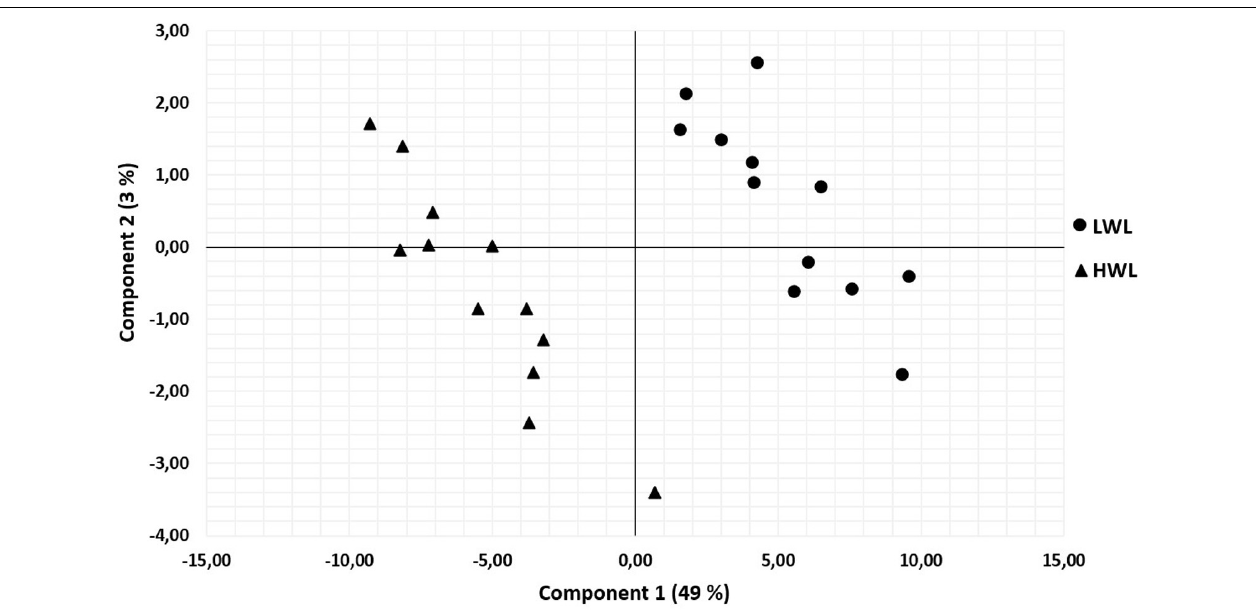
FIGURE 3 | Plot of the two first principal component score vectors showing variability according to the two liver weight groups for the 78 variant proteins ( n = 12/groups) : LWL = liver weight < 600 g = • , HWL = liver weight > 700 g = (cid:78)